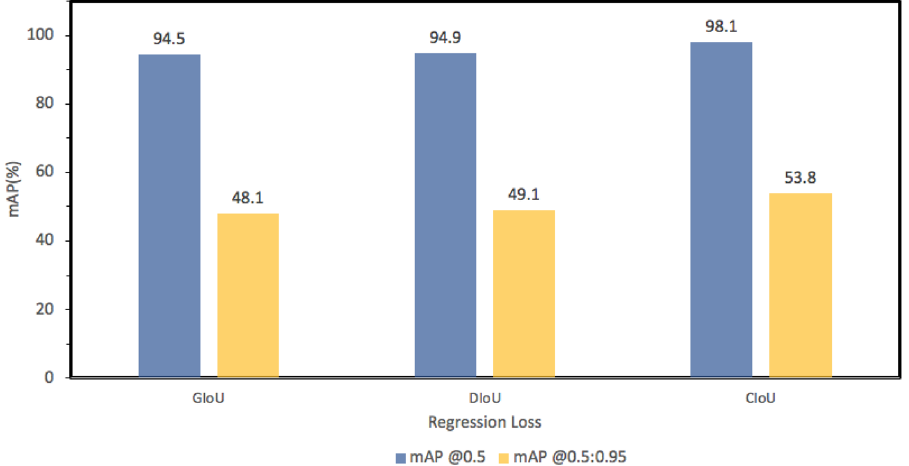
Figure 9. Regression loss comparison (RLC) showing the model’s precision (mAP) using the different regression loss functions. The CIoU loss clearly outperforms the